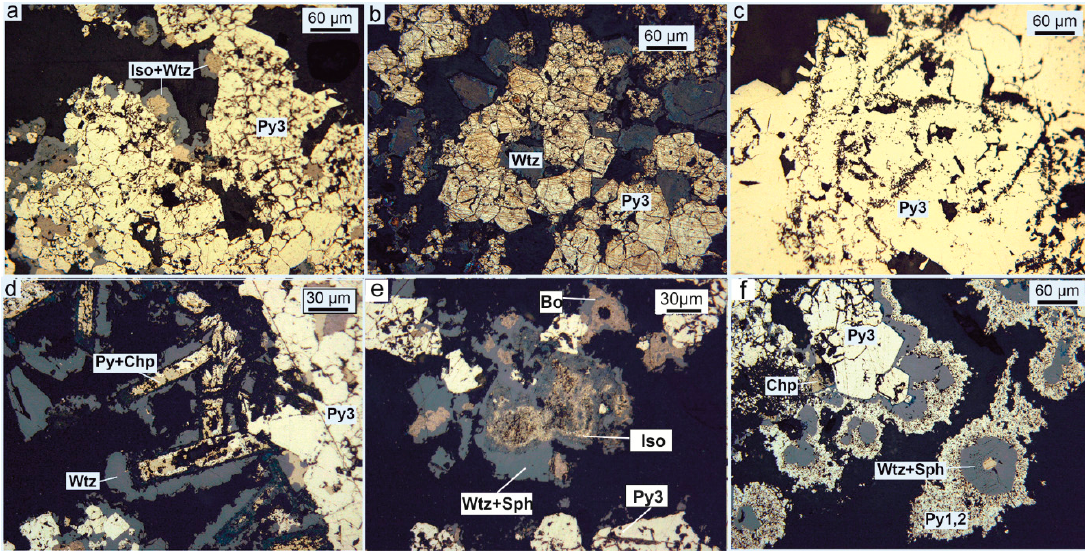
Figure 4. Pyrite-sphalerite-isocubanite microfacies (37L107d-1-2). Pobeda-2 hydrothermal field. ( a ) in granular pyrite (Py3), the walls of cavities (conduits) are overgrown by isocubanite and wurtzite (Iso+Wtz); ( b ) unzoned or poorly-zoned pyrite-3 (Py3) crystals in assemblages with wurtzite (Wtz); ( c ) relicts of pyrrhotite in coarse-grained pyrite masses (Py3); ( d ) pseudomorphs of pyrite and chalcopyrite (Py+Chp) after pyrrhotite crystals are overgrown by a rim of wurtzite (Wtz) (sample 107-11-2); ( e ) replacement of isocubanite (Iso) in the cores of wurtzite (Wtz+Sph) crystals by bornite (Bo) and minor pyrite (Py3) (in center); ( f ) sequential overgrowths of subhedral pyrite (Py3) with wurtzite (Wtz+Sph) and later fine-grained pyrite (Py1,2). Reflected light. Some pyrite varieties (b and f) are etched by HNO 3 + CaF 2 .